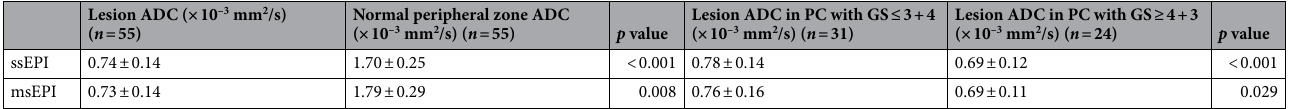
Table 4. Comparison of ADC between benign and malignant tissues, and PC with GS ≤ 3 + 4 and PC with GS ≥ 4 + 3, in ssEPI DWI and msEPI DWI.